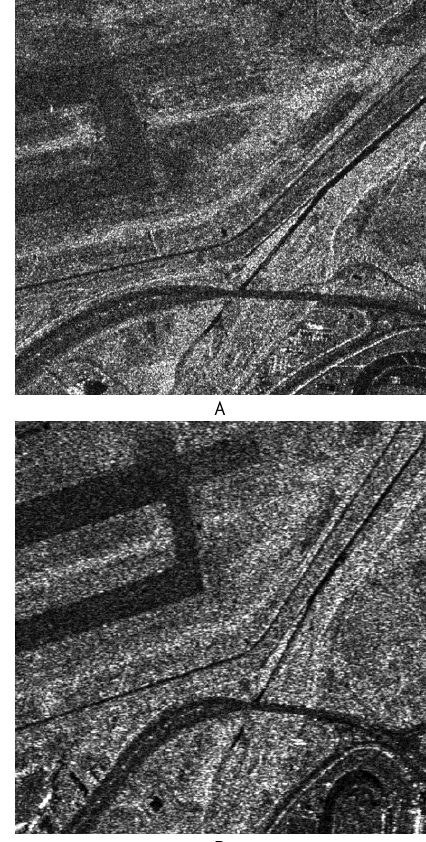
Figure 2. Master (A) and Slave (B) images by size 1000×1000 pixels that used in this